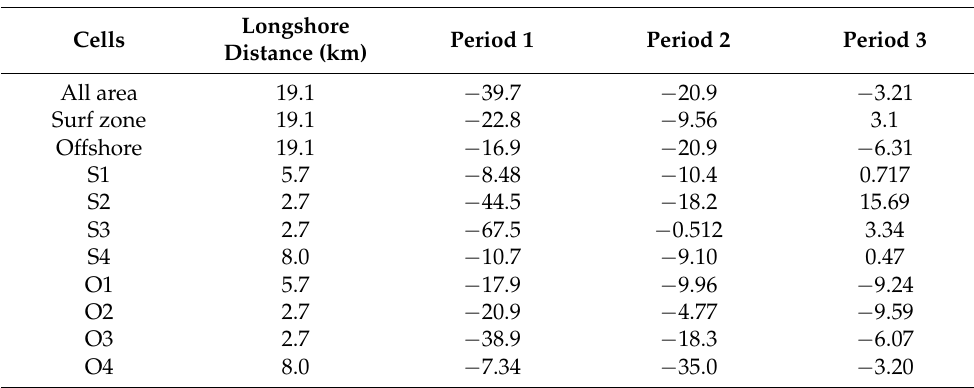
Table 1. Sediment volume trend on the Ishikawa coast, as observed in this study. The first period runs from 1969 to 1980, the second from 1980 to 1996, and the third from 1996 to 2017. Sediment Volume Trend per Unit Alongshore Length in Each Area (10 3 m 3 /km/Year) Longshore Cells Period